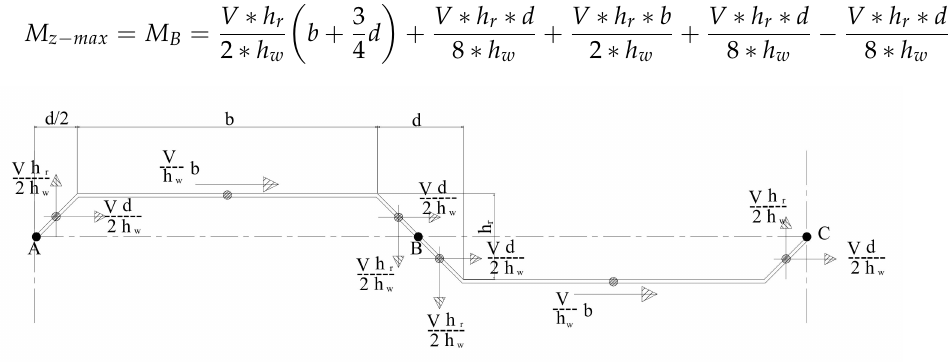
Figure 14. Illustration of the transverse bending moment